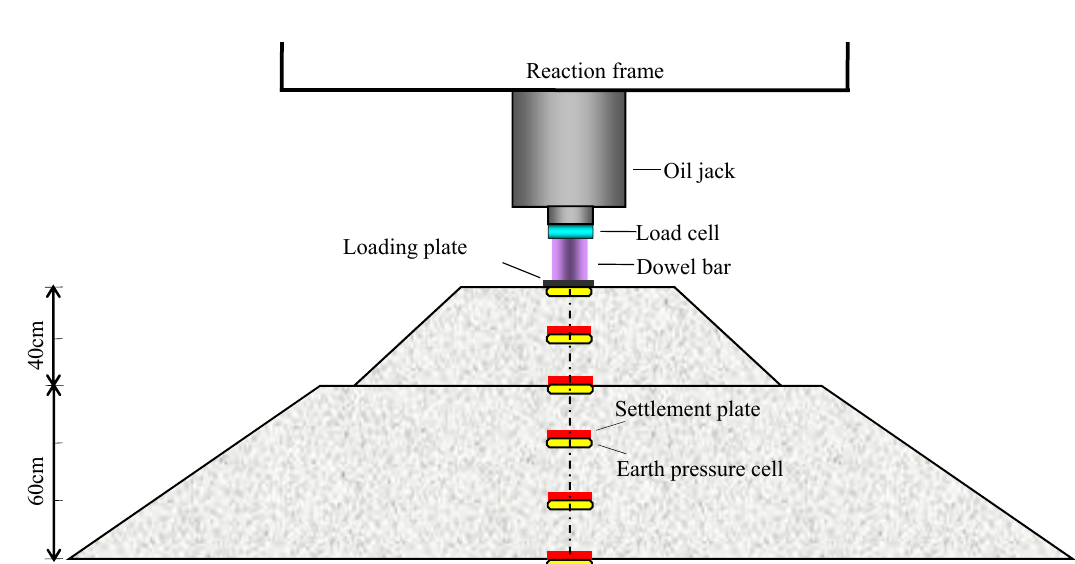
Figure 3. Loading and measuring system of the subgrade model.